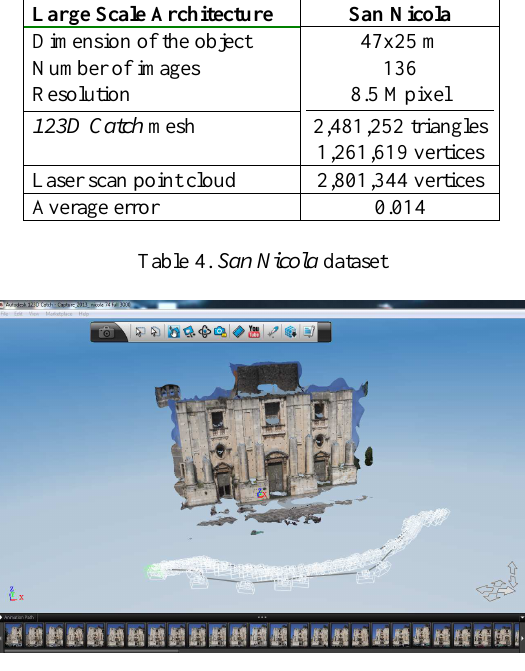
Figure 11: San Nicola façade 123D Catch model